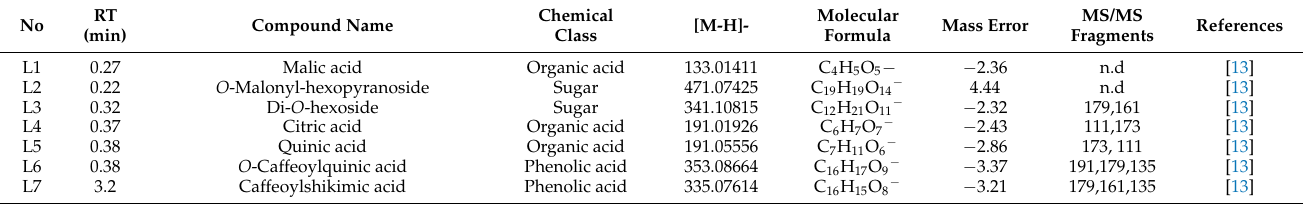
Table 2. Metabolites identified in the methanol extract of Luwak coffee via UPLC-PDA-ESI-HRMS in negative